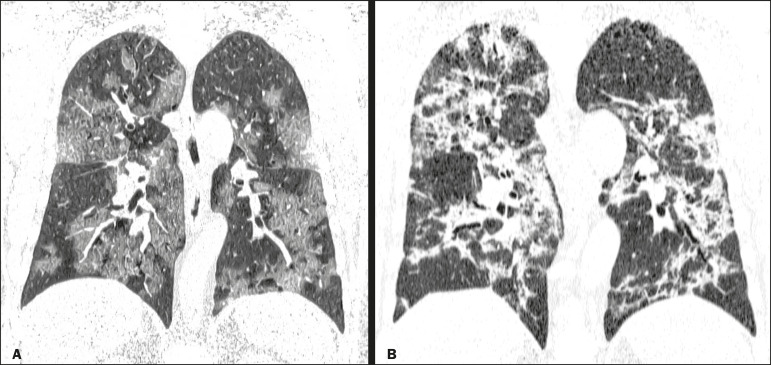
A 48-year-old male patient at 10 days after symptom onset. A: CT reconstruction in the coronal plane, showing a diffuse crazy-paving pattern (a stage 2 finding). B: At 21 days after symptom onset, this patient was admitted to the intensive care unit with a diffuse pattern of consolidations due to organizing pneumonia (a stage 3 finding).